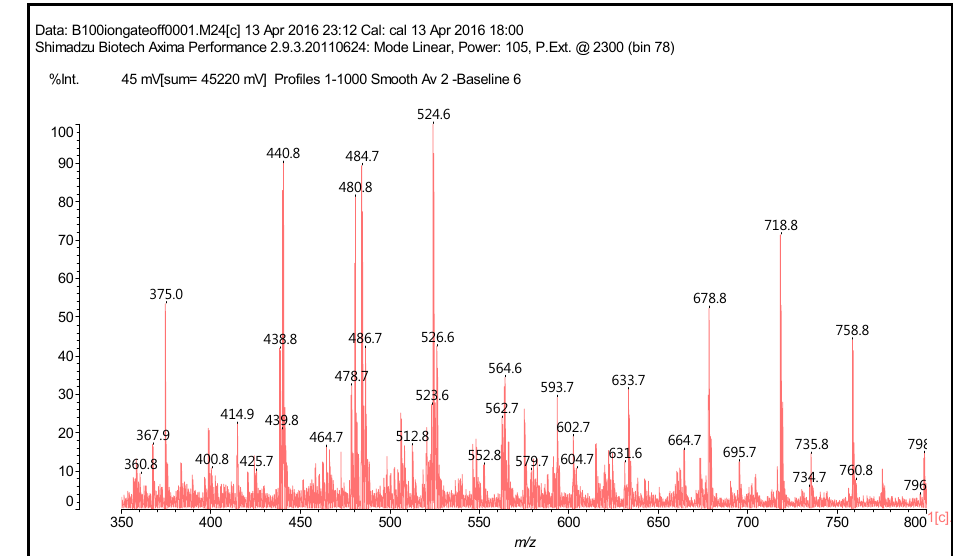
Figure 2. MALDI-ToF spectrum of the reaction of catechin with hexamethylene diamine at 185 °C, NaOH-catalysed. Range 350–800 Da.